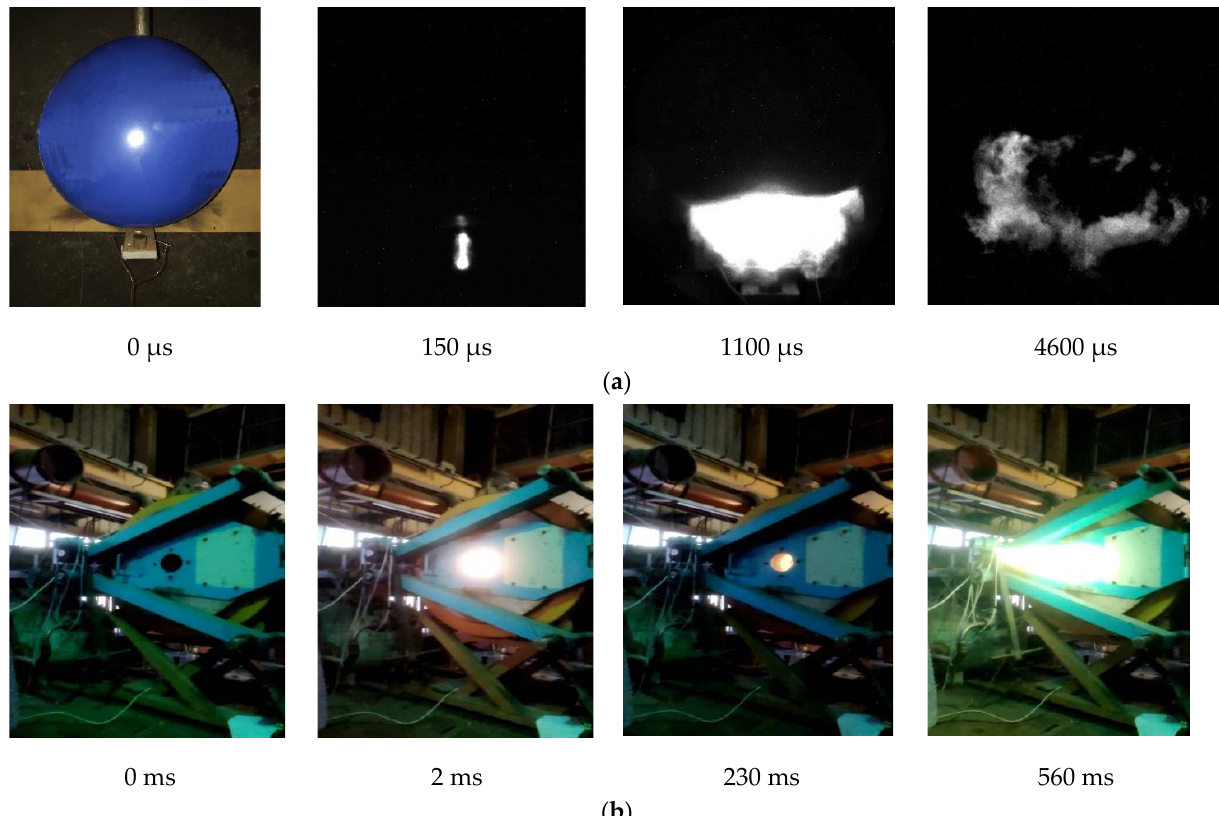
Figure 3. Photographs of a propane-butane gas mixture ignition process. ( a ) Inside the chamber: 150 μs— jet flame of thermite mixture combustion products; 1100 μs— coverage of the rubber shell by the combustion products of the thermite mixture; 4600 μs— destruction of the rubber shell and beginning of the outflow of the propane-butane gas mixture into the air volume of the chamber. ( b ) Outside the chamber: 2 ms—radiation from the flame of the thermal mixture combustion products; 230 ms—radiation of the incipient ignition of the propane-butane-air mixture inside the chamber; 560 ms — emission and combustion of a propane-butane-air mixture outside the chamber.